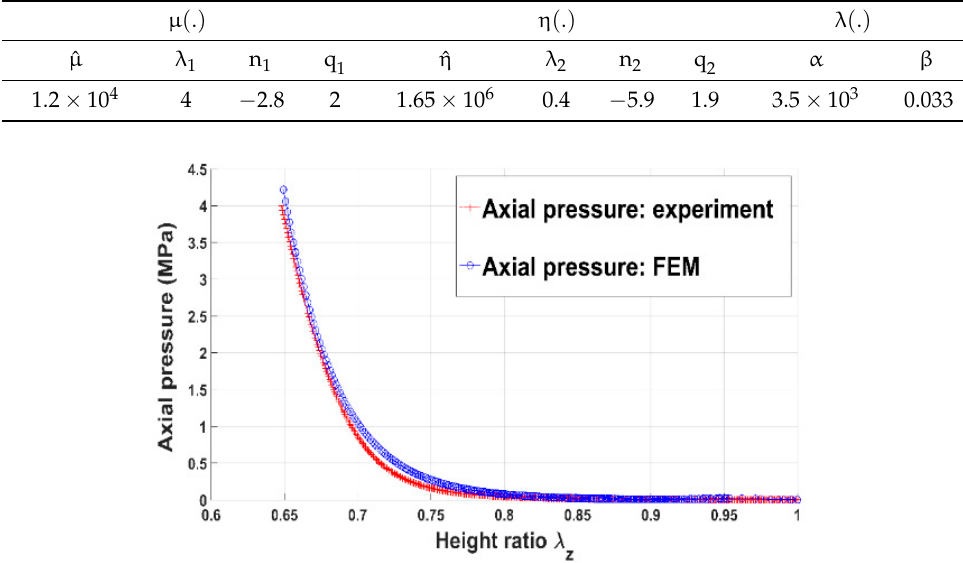
Figure 17. Axial pressure: FEM vs. experiment.